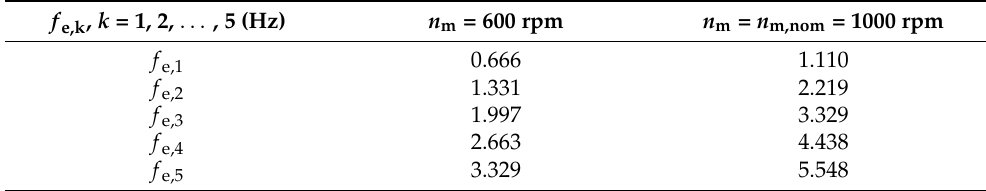
Table 1. The frequencies of the first five harmonics ( f e,k , k = 1, 2, . . . , 5) of excitation caused by the resistance to excavation.